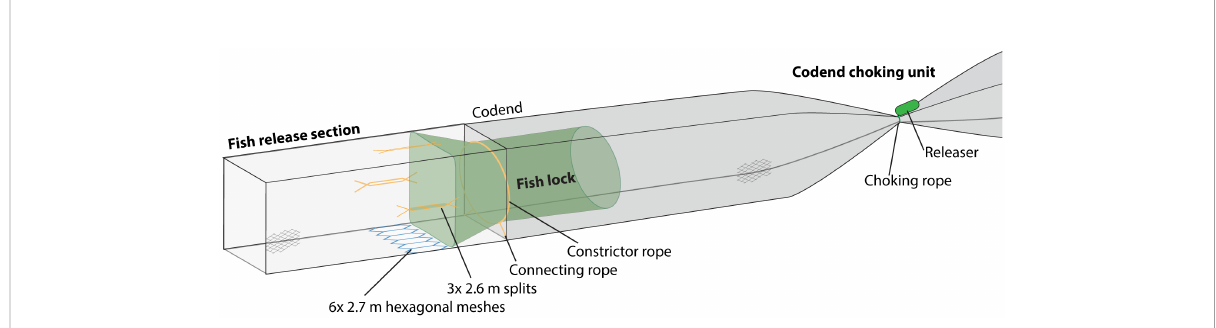
FIGURE 1 Catch limitation system – general overview illustrating Rig 4 with fi sh lock 2: Consists of a four-panel cylinder of netting, 10-16 m long, inserted between the trawl and codend, that incorporates two key components: escape openings and a “ fi sh lock ” . The rig should allow free passage of the catch from the trawl into the codend during the fi shing process, until the codend is full. The escape openings therefore should prevent escape during the normal fi shing process, but once the codend is full should then enable fi sh to escape freely with minimal risk of crowding and abrasive injury. The fi sh lock should permit free passage into the codend during the normal fi shing operation. But, once the codend is full and/or during heaving, the catch on the codend side of the fi sh lock should press against the fi sh lock netting, closing it, and preventing any loss of the catch retained in the codend through the escape opening. The catch limit release mechanism releases the retained catch into the residual codend during haulback (see section 4).